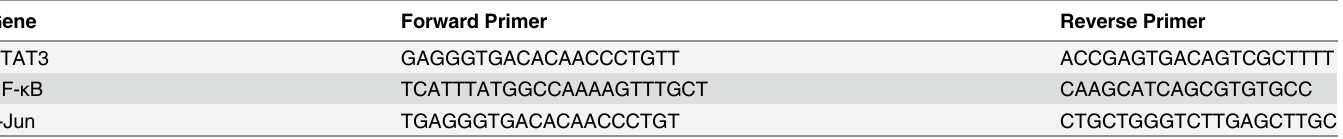
Table 1. The sequence of primers used for ChIP